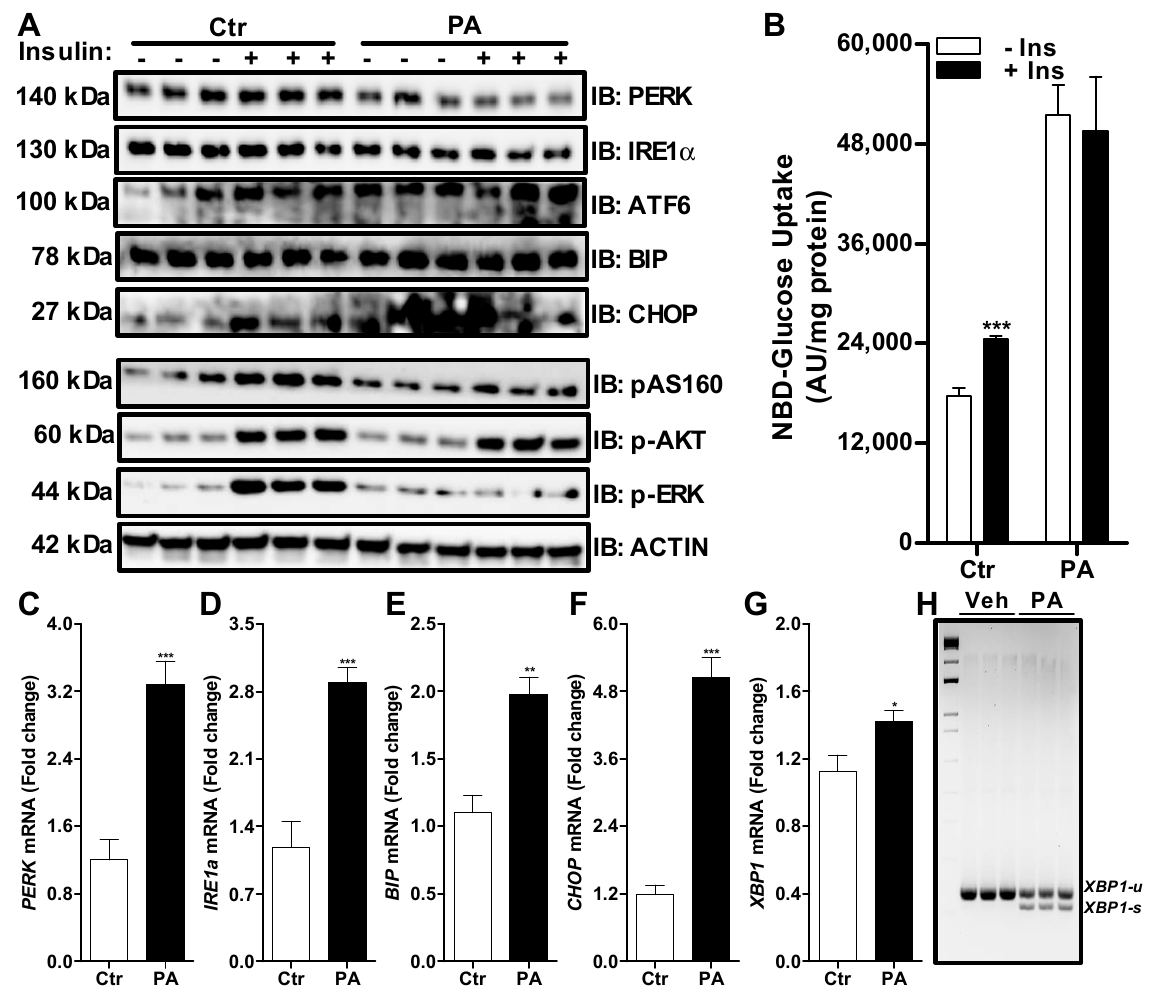
Ctr Figure 2. Palmitate induces both an alteration in ER stress and insulin signaling in Huh-7 cells. Huh-7 cells were treated without (Ctr) or with 0.2 mM of palmitate (PA) for 16 h prior to a 15 min challenge with 250 nM of bovine insulin. Cells were used to measure the expression of different ER stress and downstream insulin signaling pathway proteins by Western blotting (Panel A ). In a separate experiment, cells were used to determine the uptake of 2-NBD glucose for 1 h in triplicate after the insulin challenge (Panel B ). Cells were also used for the extraction of total RNA to measure the expression of various ER stress genes by qRT-PCR (Panels C – G ). Unspliced (u) and spliced (s) forms of XBP1 mRNA were measured by RT-PCR (Panel H ). Values were plotted as mean ± SD. p values were calculated using Student’s t test. *, p < 0.05; **, p < 0.01; ***, p < 0.001. 3.3. Oleate Prevents Palmitate-Induced ER Stress without Affecting Insulin Signaling in Huh-7 Cells To evaluate the differential effects of palmitate and oleate on ER stress in liver cells, we examined their effects on the expression of the ER stress markers in Huh-7 cells. As seen before (Figure 2), treatment with palmitate significantly increased the expression of ER stress genes compared to control-treated cells (Figure 4C–H). Unlike tunicamycin and palmitate (Figures 1 and 2), 0.2 mM of oleate did not induce the expression of ER stress markers (Figure 4A,C–G). Oleate was also unable to induce the splicing of XBP1 mRNA (Figure 4H). On the other hand, palmitate-induced ER stress markers and XBP1 splicing were prevented in the presence of oleate (Figure 4C–H). These results suggest that oleate prevents the palmitate-induced expression of ER stress genes in Huh-7